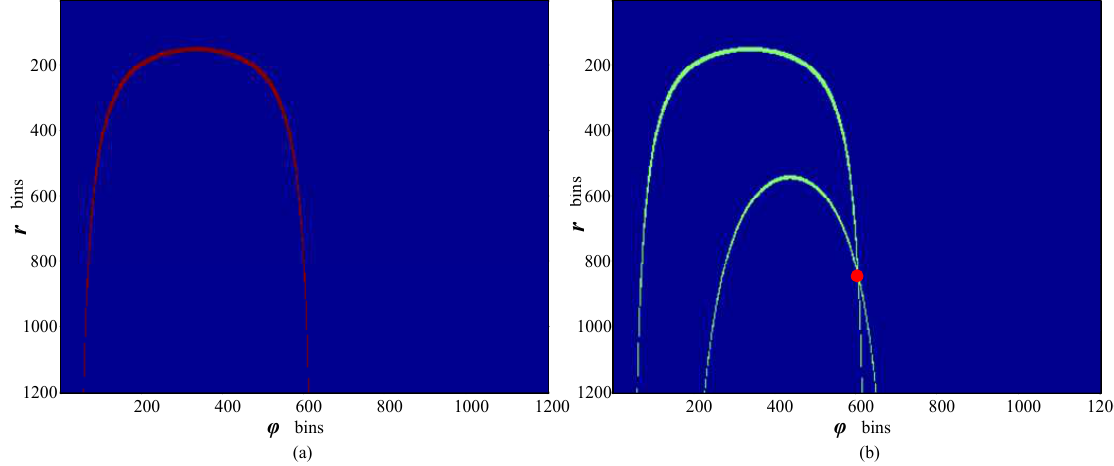
Figure 3. Position estimation of the scatterer located at (3, 0): ( a ) using single frequency set; and ( b ) using two frequency